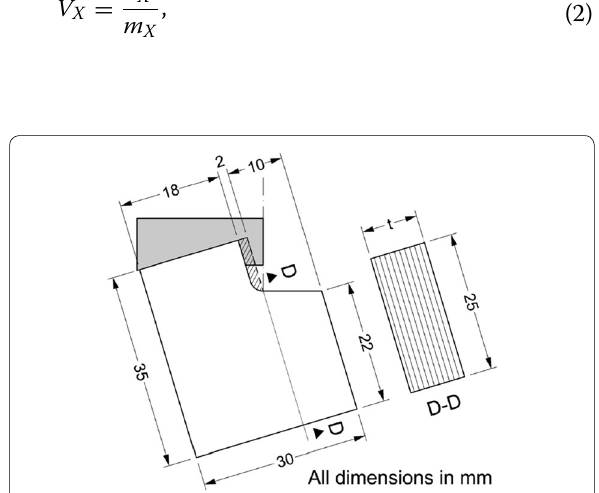
Fig. 5 Detail of robotically fabricated shear sample and matching jig holding